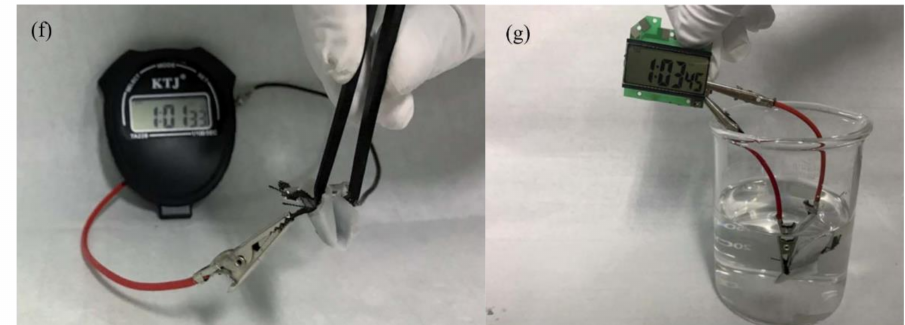
Figure 16. ( a ) Cycling stability of the solid-state ZIBs with KCR electrolyte cycled at 6.0 A · g − 1 and corresponding coulombic efficiency. SEM images of ( b ) the MnO 2 cathode and ( c ) the electroplated Zn anode after 450 charge/discharge cycles. ( d ) Discharge curves under normal and bending conditions. ( e ) The bending test of solid-state ZIBs with KCR electrolyte for 300 cycles. ( f ) A solid-state ZIB with KCR electrolyte powers a timer under 180 degrees of bending conditions. ( g ) A solid-state ZIB with KCR electrolyte powers a timer when the battery is fully immersed in the water.